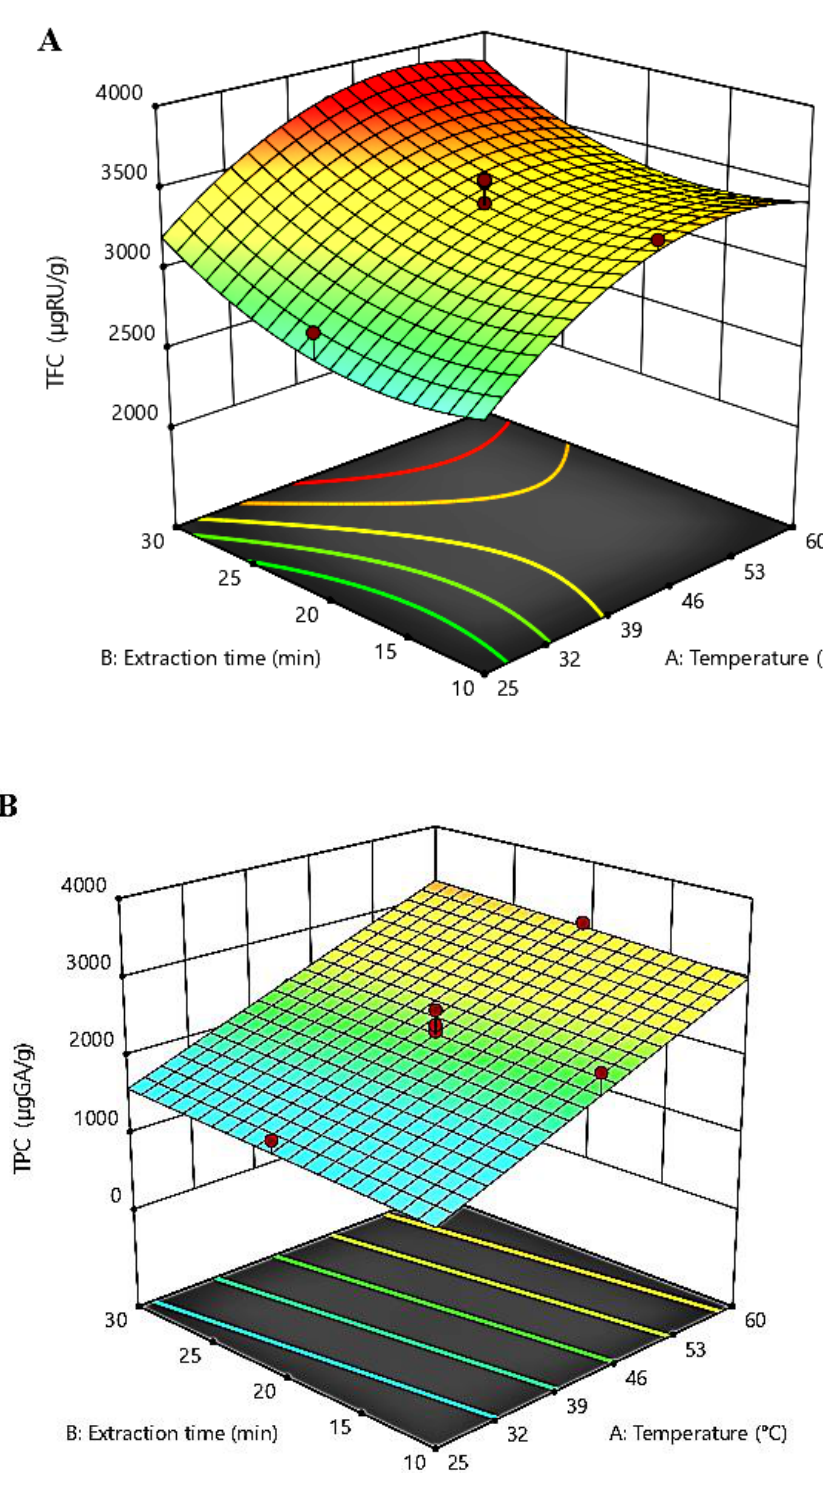
Figure 1. Response surface plots of significant model terms for ethanol extract: A − TFC (total flavonoid content) and B − TPC (total phenolic content), and effect of extraction temperature and extraction